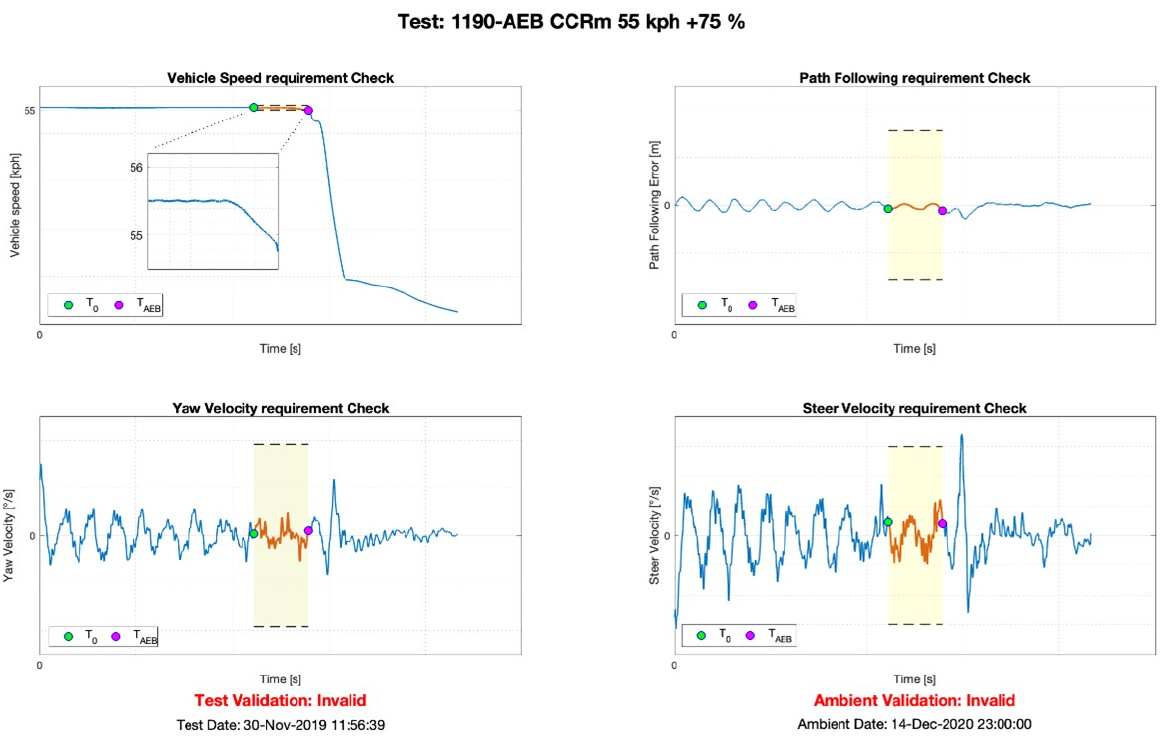
Figure 22. Post-processing results for invalid test CCRm.